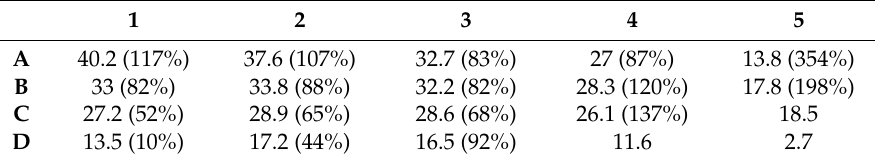
Table 7. SNR (dB) for the F -statistic on step heating thermal data.